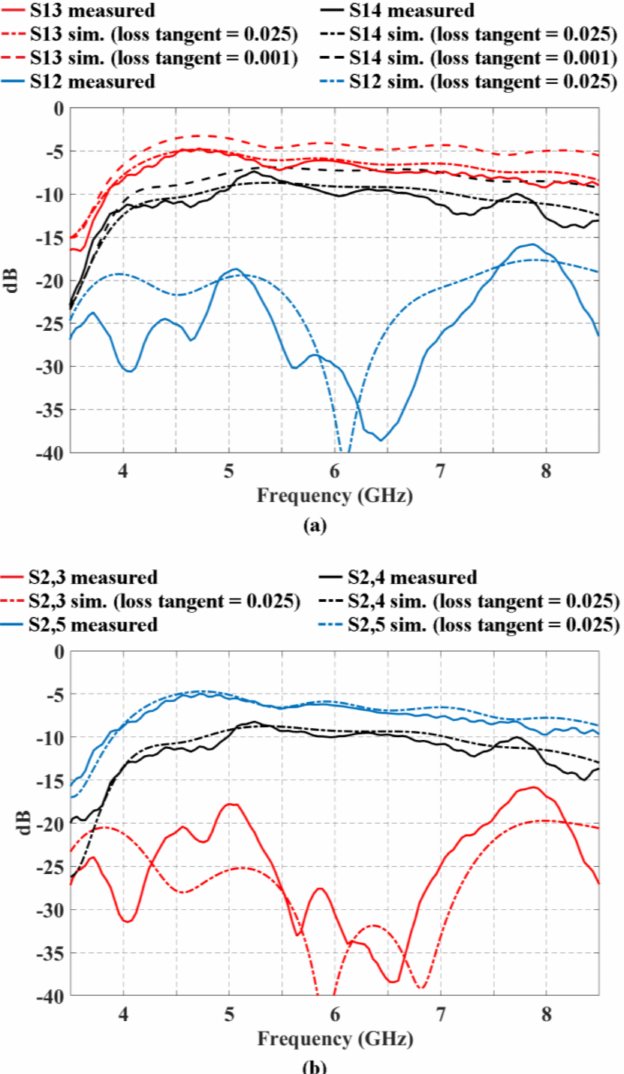
Figure 6. Behavior of the transmission coefficients for the block of 2 × 3 CORPS network using the substrate FR4 for a tangent loss of 0.025 and its comparison with respect to a value of tangent loss of